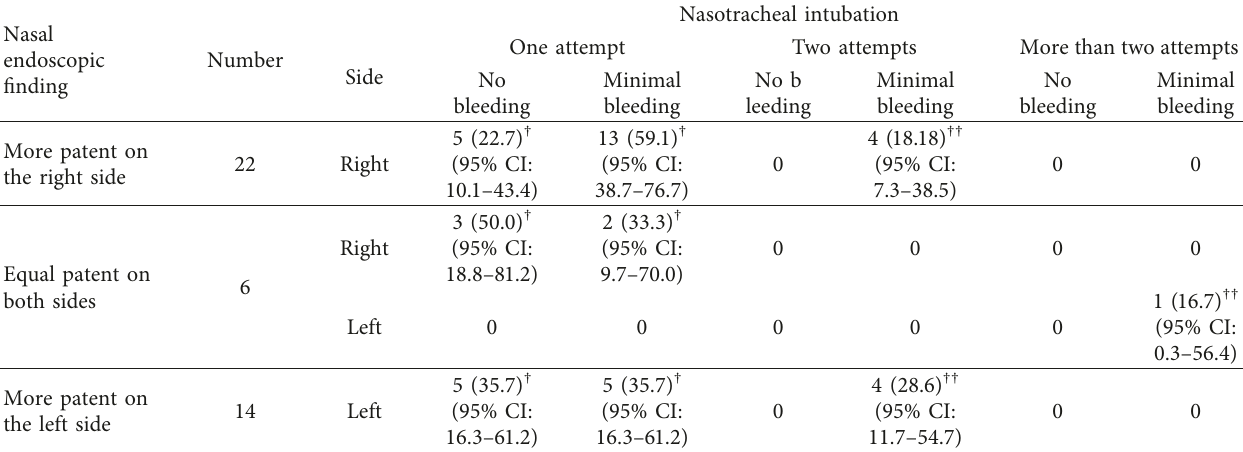
Table 3: Comparison of epistaxis complication between right and left nasotracheal intubation.